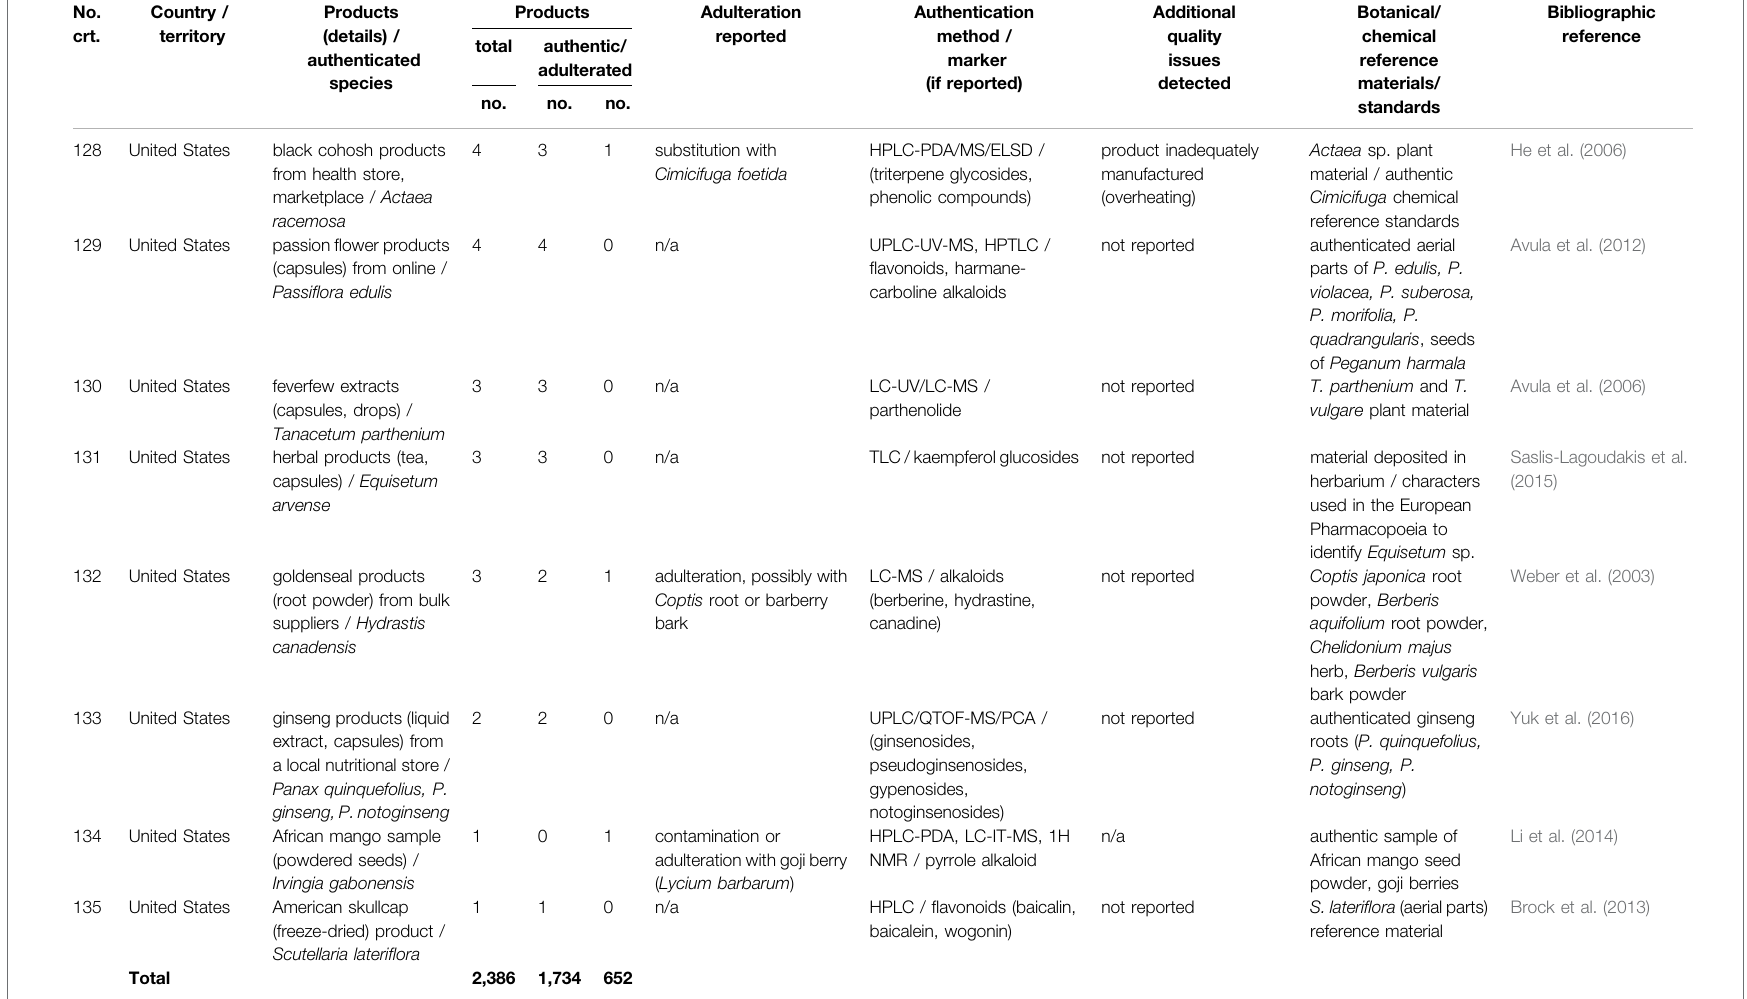
TABLE 1 | ( Continued ) The authenticity of the chemically authenticated commercial herbal products at global